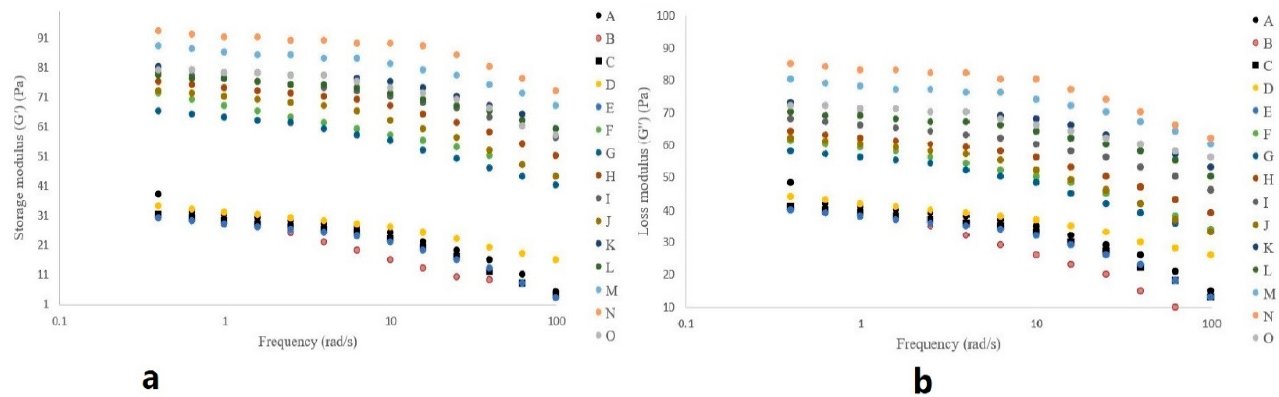
Figure 3. ( a ) Frequency sweep profile of the samples with two biopolymers (FG and XG for elastic modulus (G ′ ) changes (Strain: 0.1%) ( b ) Frequency sweep profile of the samples with two biopolymers (FG and XG) for loss modulus (G ″ ) changes (Strain: 0.1%). Table 5. Frequency sweep parameters of the emulsions containing two hydrocolloids (fenugreek galactomannan and xanthan gum) (Angular frequency = 0.1–100%, strain%: 0.1%, 25 ◦